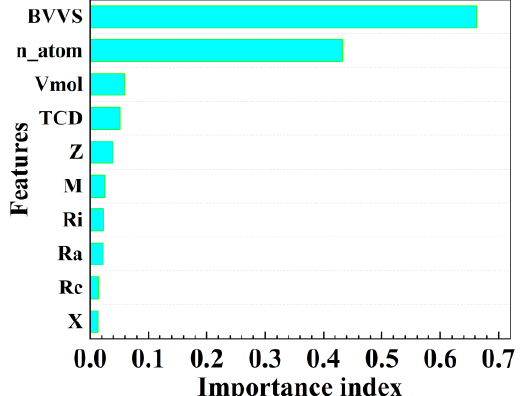
Figure 5. Importance histogram of characteristic variables.